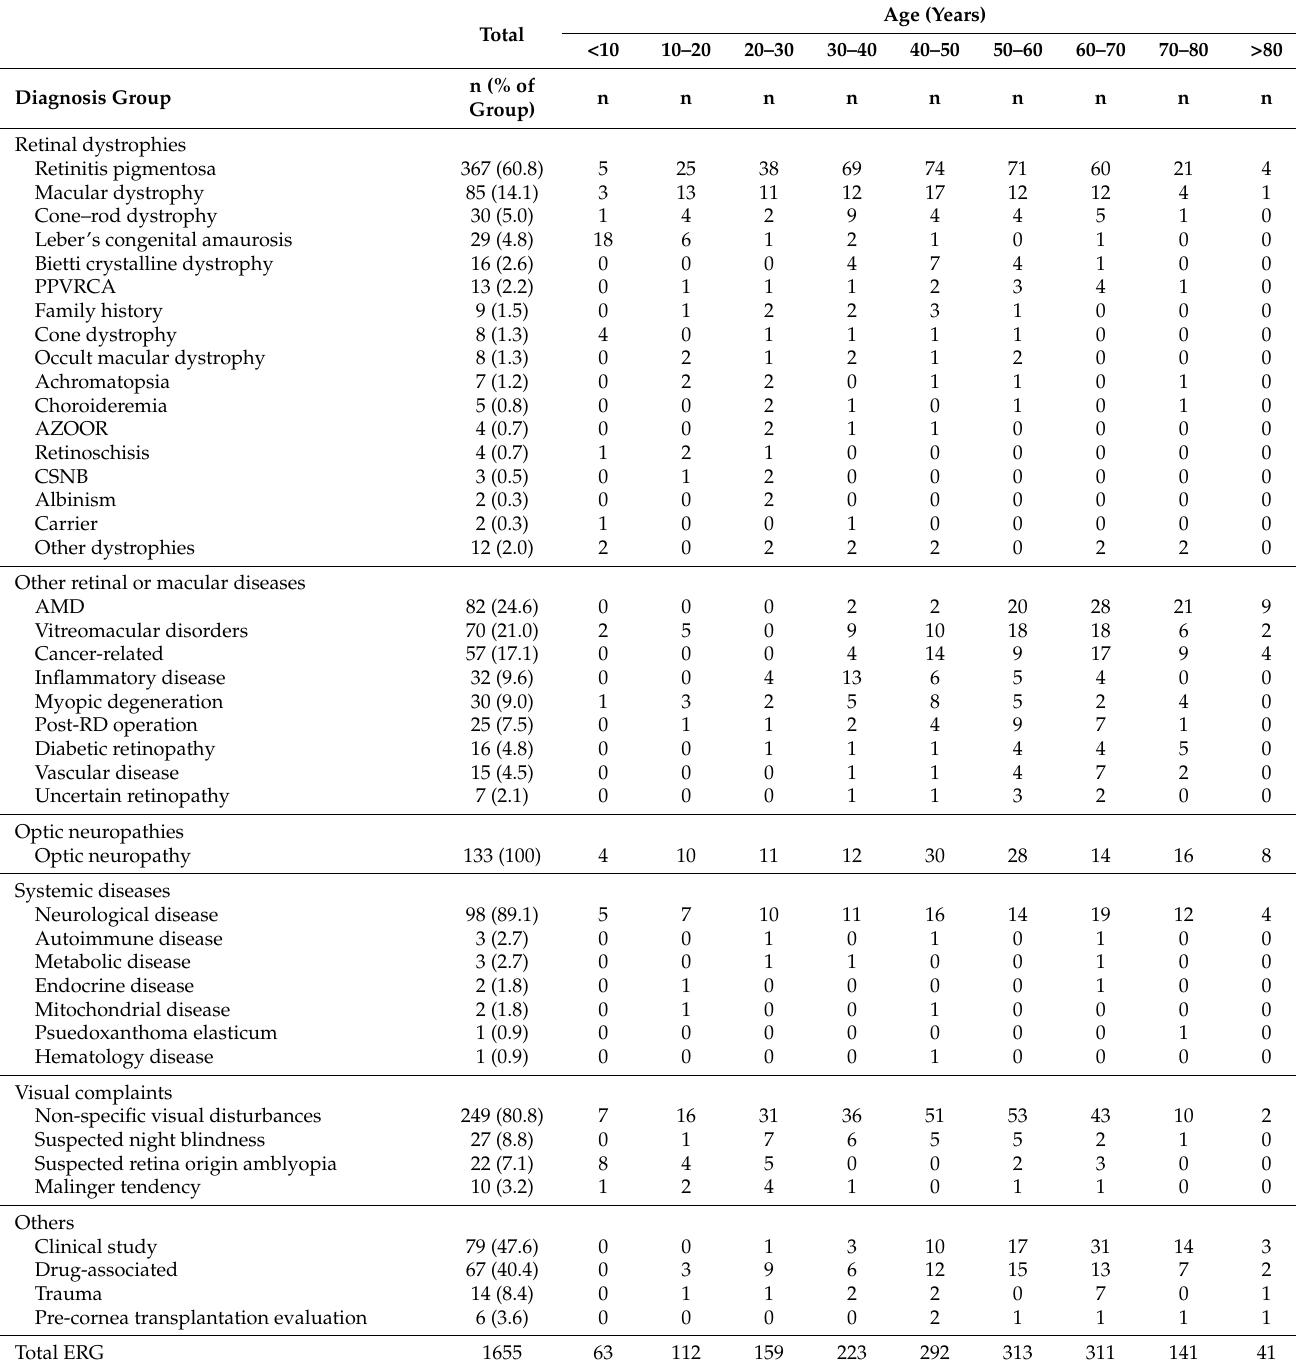
Table 1. Patient diagnoses and their age distributions at their first full-field ERG in the six diagnosis